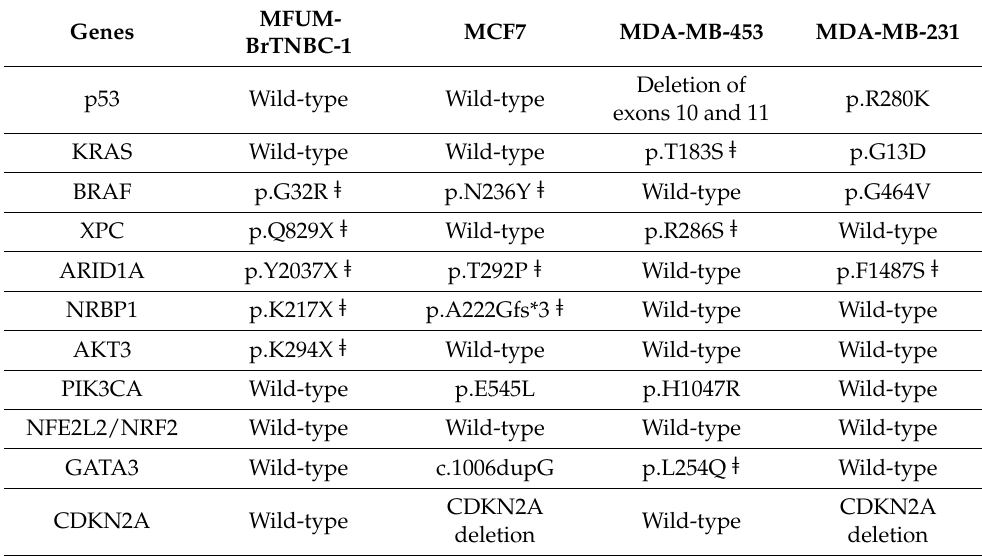
Table 2. Deleterious mutations in MFUM-BrTNBC-1, MCF-7, MDA-MB-453 and MDA-MB-231.